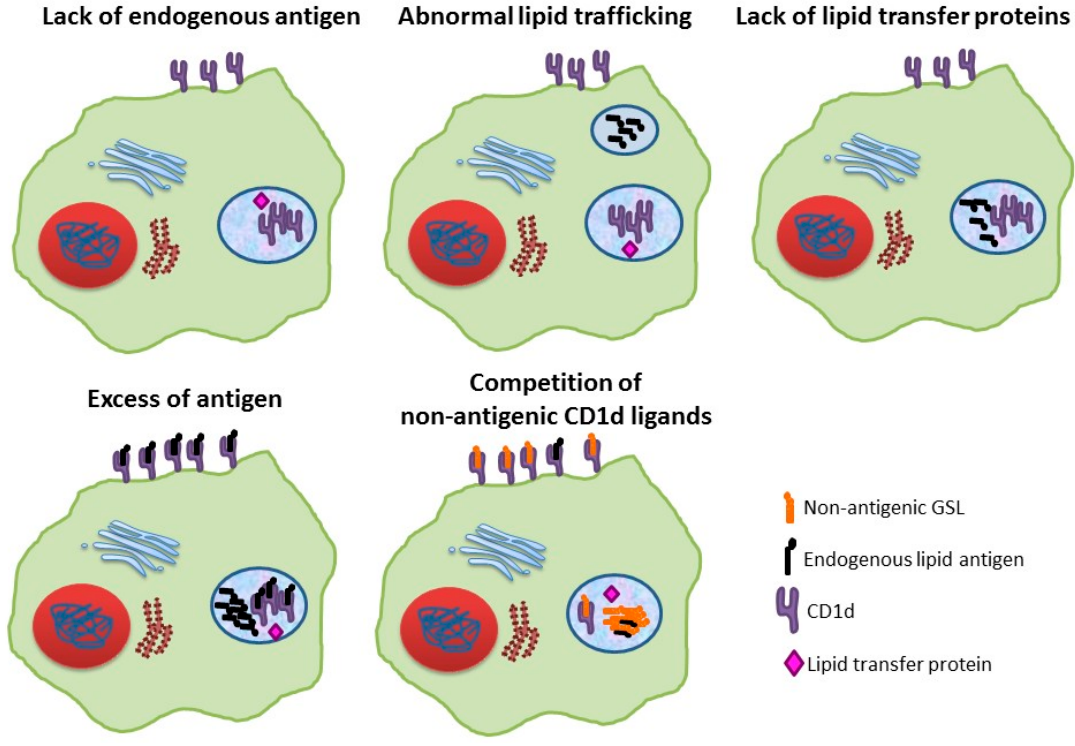
Figure 1. Proposed mechanisms, occurring in the antigen-presenting cell, that can explain invariant Natural Killer T (iNKT) cell defects in lysosomal storage diseases (LSDs). GSL, glycosphingolipid.